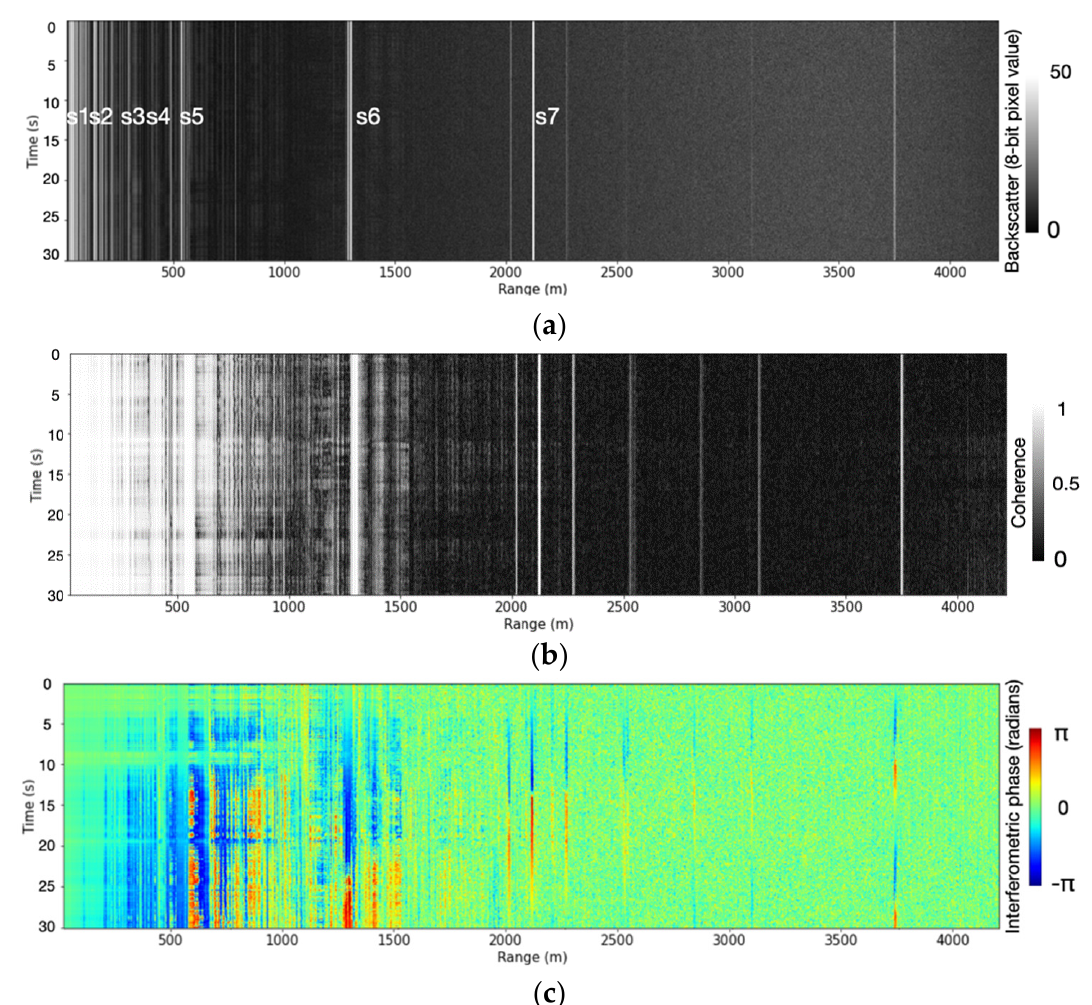
Figure 7. Stare-mode acquisition acquired 4 March 2020 and derived backscatter ( a ), coherence ( b ) and interferometric phase ( c ). Strong scatterers s5–s7 can be identified in ( a ). σ 0 is not calculated in ( a ) as absolute calibration was not performed.